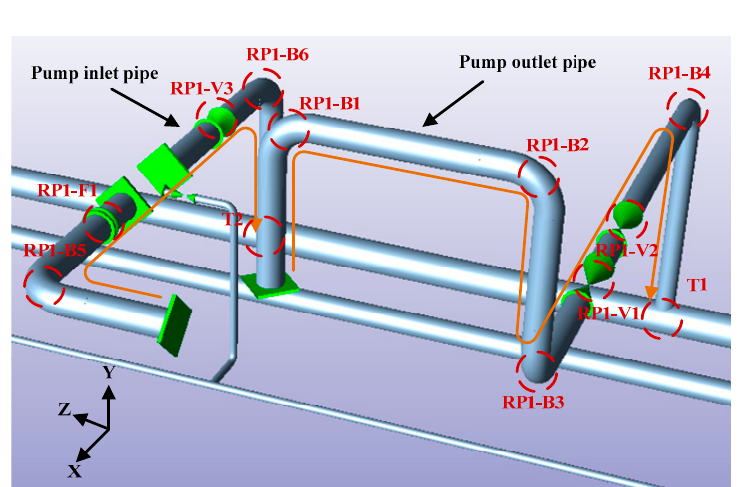
Figure 19. The location of the unbalanced exciting force.